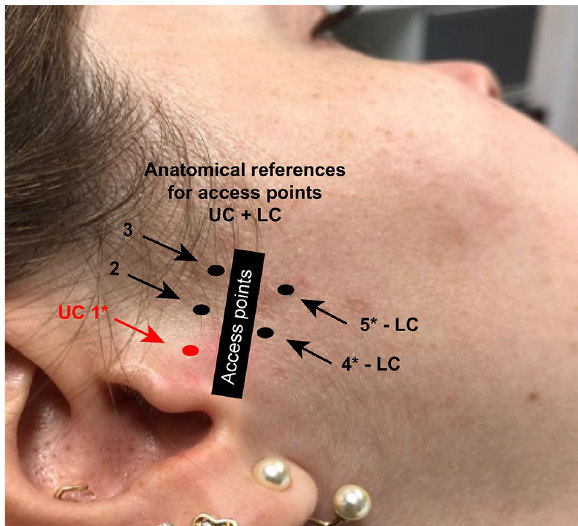
Figure 7. Reference points proposed by the evaluated